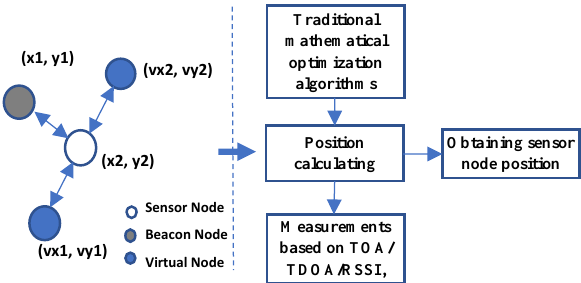
Figure 2. Single beacon-based mobile sensor nodes localization using traditional mathematical optimization algorithm in WSN